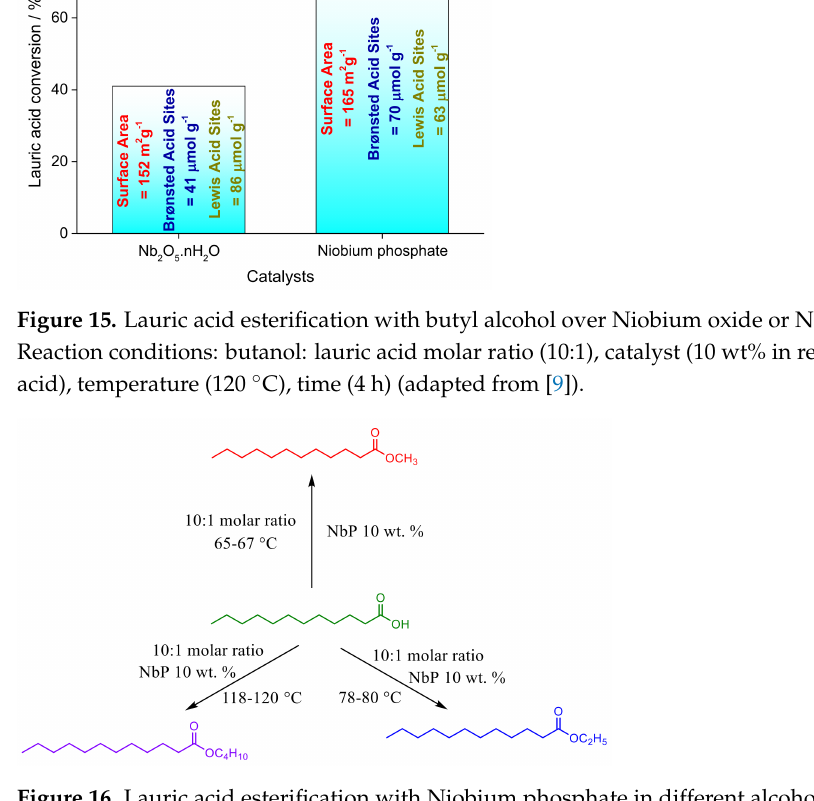
Figure 16. Lauric acid esterification with Niobium phosphate in different alcohols. Reaction condi- tions: alcohol: lauric acid molar ratio (10:1), catalyst (10 wt% in relation to the lauric acid), reflux temperature (methyl alcohol = 65–67 ◦ C; in ethyl alcohol = 78–80 ◦ C; in 1-butyl alcohol = 118–120 ◦ C), time (4 h) (adapted from